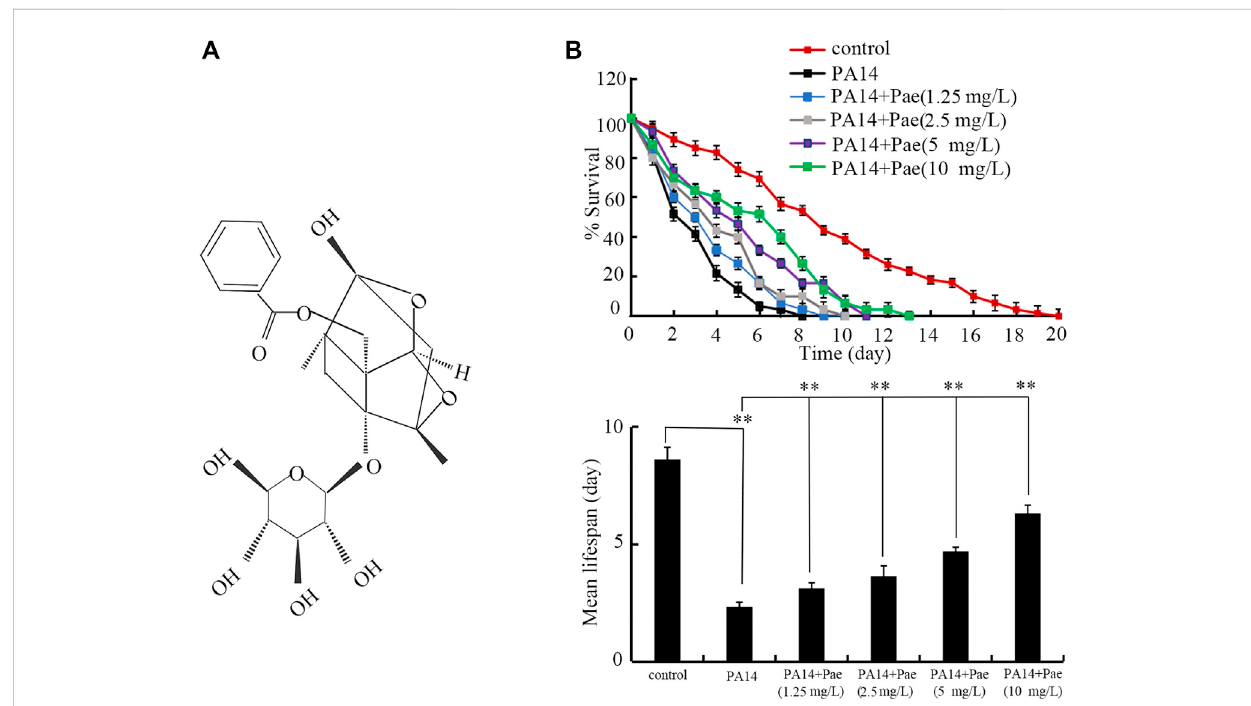
FIGURE 1 Effect ofpaeoni fl orintreatmentinincreasinglifespan in P.aeruginosa PA14infectednematodes. (A) Chemicalstructureofpaeoni fl orin. (B) Effect of paeoni fl orin treatment on lifespan of nematodes infected with P. aeruginosa PA14. Lifespan curve of PA14 showed a signi fi cant difference ( p < 0.01) compared to control. Lifespan curves of PA14 + Pae (1.25 mg/L), PA14 + Pae (2.5 mg/L), PA14 + Pae (5 mg/L), and PA14 + Pae (10 mg/L) showed a signi fi cant difference ( p < 0.01) compared to PA14. Pae, paeoni fl orin. ** p <